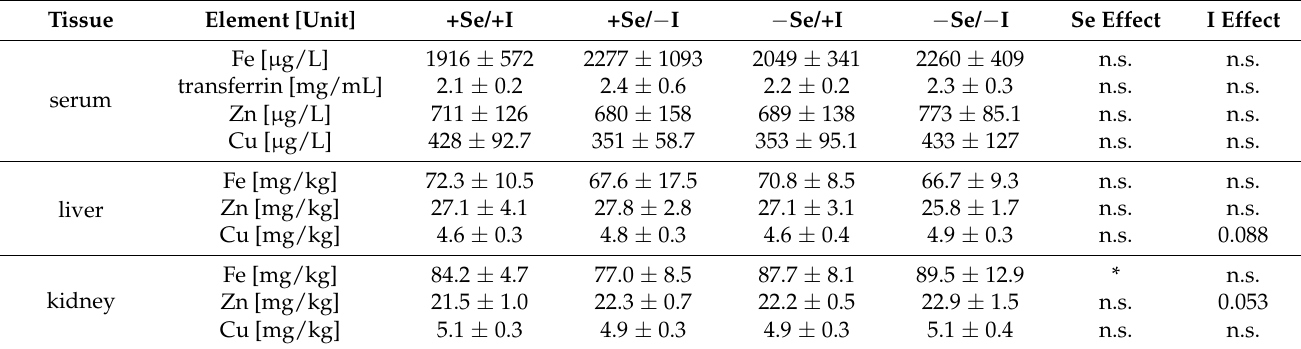
Table 2. Impact of low or adequate selenium and iodine supply on iron, zinc, and copper homeostasis. Concentrations of trace elements or functional markers for iron (Fe), zinc (Zn), and copper (Cu) in serum, liver, and kidney detected by ICP-MS and ELISA in male C57BL/6Jrj mice ( n = 7). Data are presented as mean ± standard deviation. Statistical testing based on Two-Way ANOVA and post hoc analysis using Bonferroni’s test with * p < 0.05. n.s. not significant.